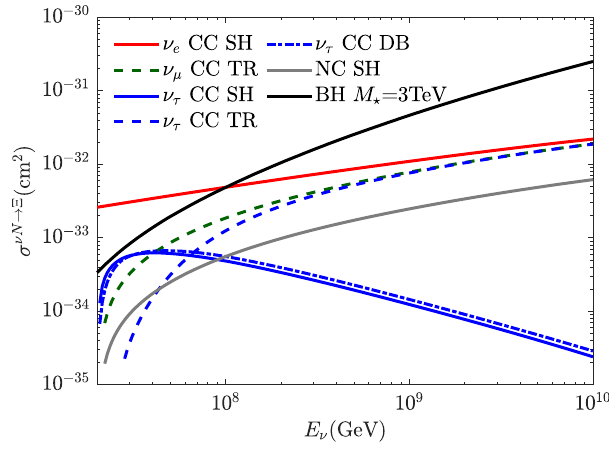
Figure 3 . Total neutrino-nucleon interaction cross section with di(cid:11)erent topologies as a function of incoming neutrino energies. Standard Model showers, tracks and double bangs are shown in solid, dashed and dashed-dotted lines respectively, noting that black hole events will produce all three topologies. The contributions from neutrinos and antineutrinos have been averaged over. In produc- ing the cross sections we require a minimum energy deposition of 20 PeV. See appendix A for